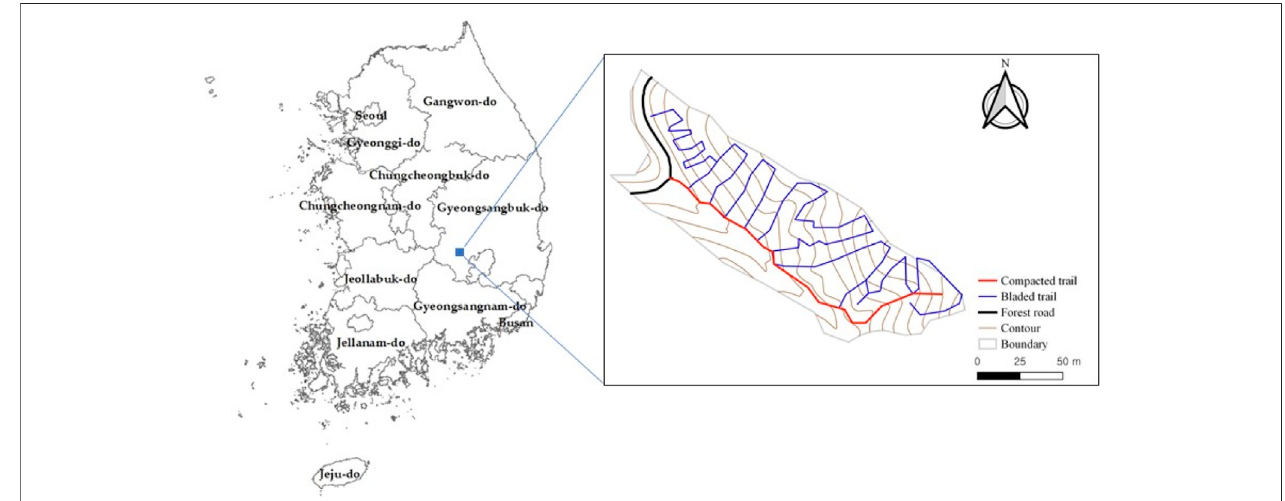
FIGURE 1 | Map of the study area.